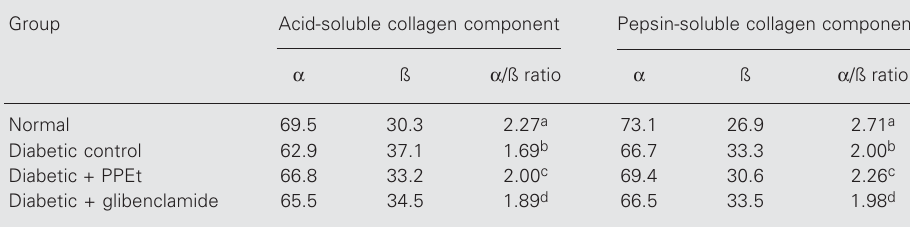
Table 4. Effect of Phaseolus vulgaris pod extract (PPEt) on the α /ß ratio of acid- and pepsin-soluble collagen in tail tendon of normal and diabetic